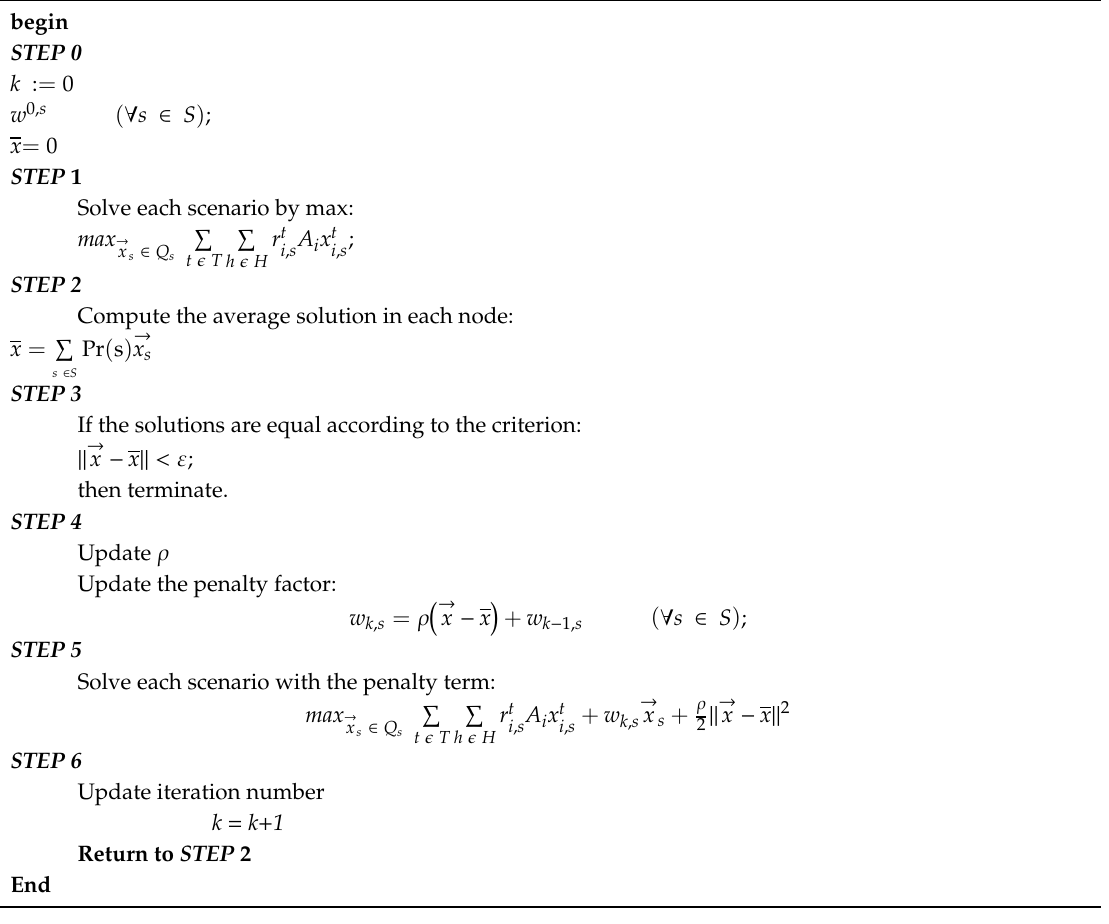
Algorithm 1. Progressive